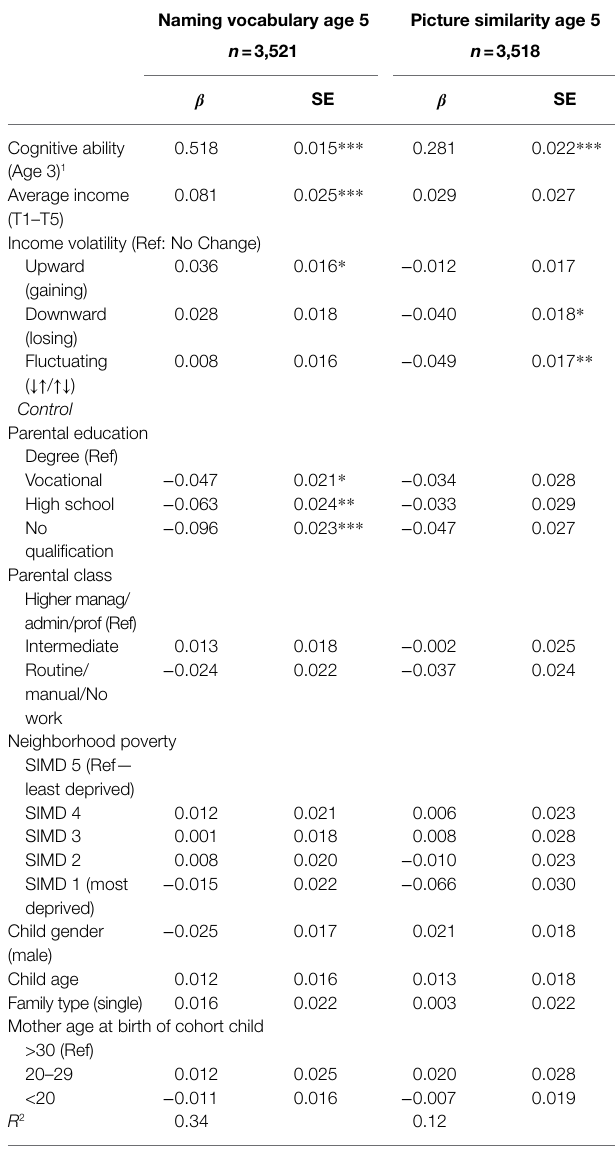
TABLE 2 | Bivariate association between family socioeconomic characteristics and forms of income volatility.